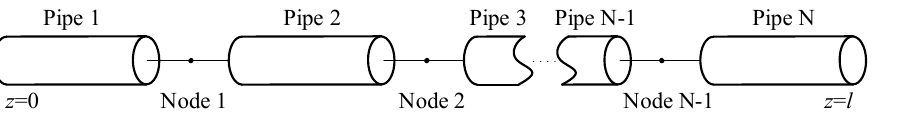
Figure 4. Schematic of the cascaded pipe units and nodes. Reprinted with permission from Ref. [24]. Copyright © 2013 Elsevier Ltd. All rights reserved.